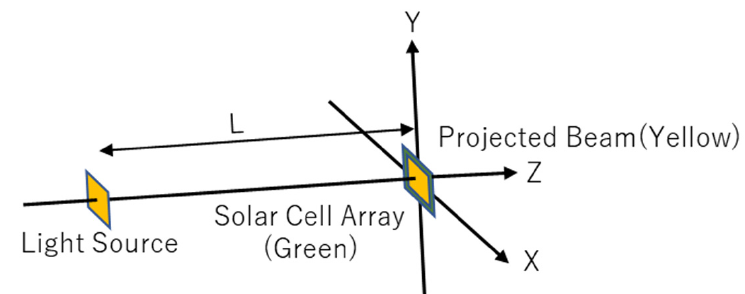
Figure 2. Configuration of this analysis.